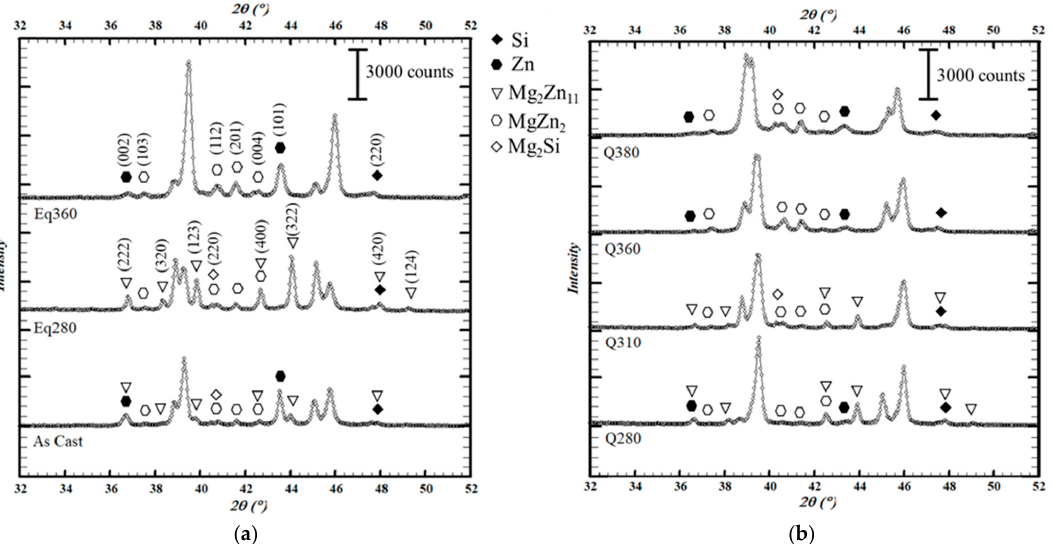
Figure 7. Diffraction patterns of the samples in each thermal condition at 30 °C prior to the heating cycle in the thermo-diffractometer. Indexation is shown above the patterns of samples Eq280 (Mg 2 Zn 11 and Mg 2 Si phases) and Eq360 (Si, Zn and MgZn 2 phases). Peaks corresponding to Al and Pt phases (the latter from the sample holder) are omitted for clarity. ( a ) As-cast samples and those cooled slowly. ( b ) Quenched samples.